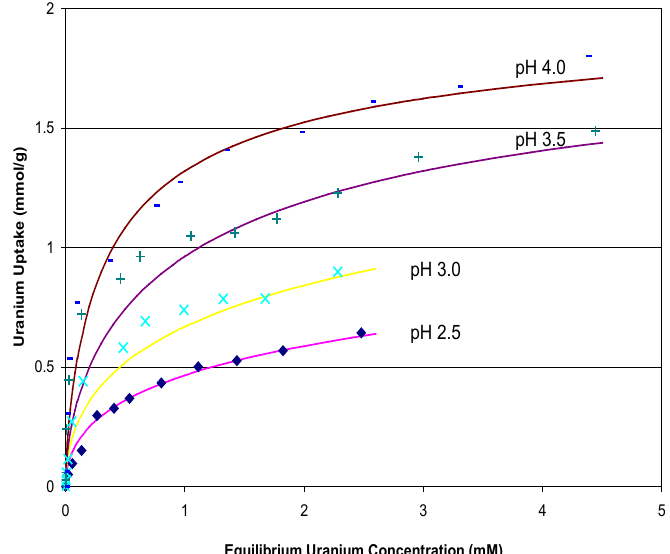
Fig. 9 . Fig. 9. Comparison of experimental uranium isotherms and HIEM calculation at different solution